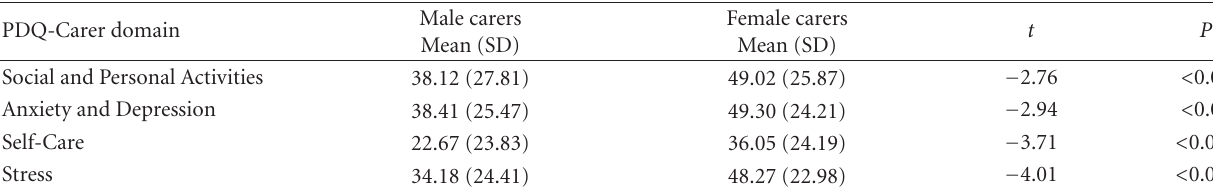
Table 2: Comparisons of carer quality of life by